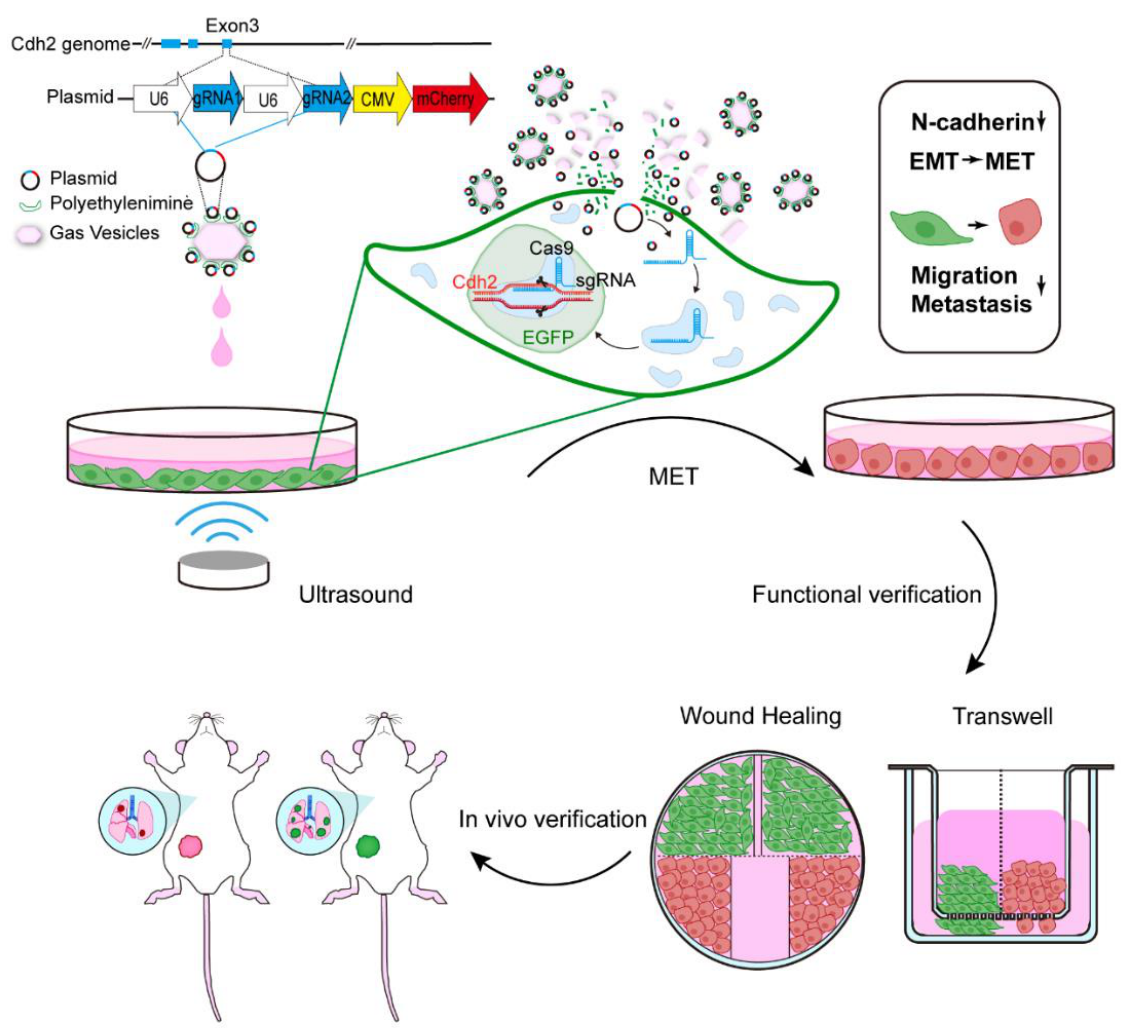
Figure 1. Schematic diagram of ultrasound-mediated CRISPR/Cas9 gene editing of Cdh2 to inhibit tumor invasion and metastasis.